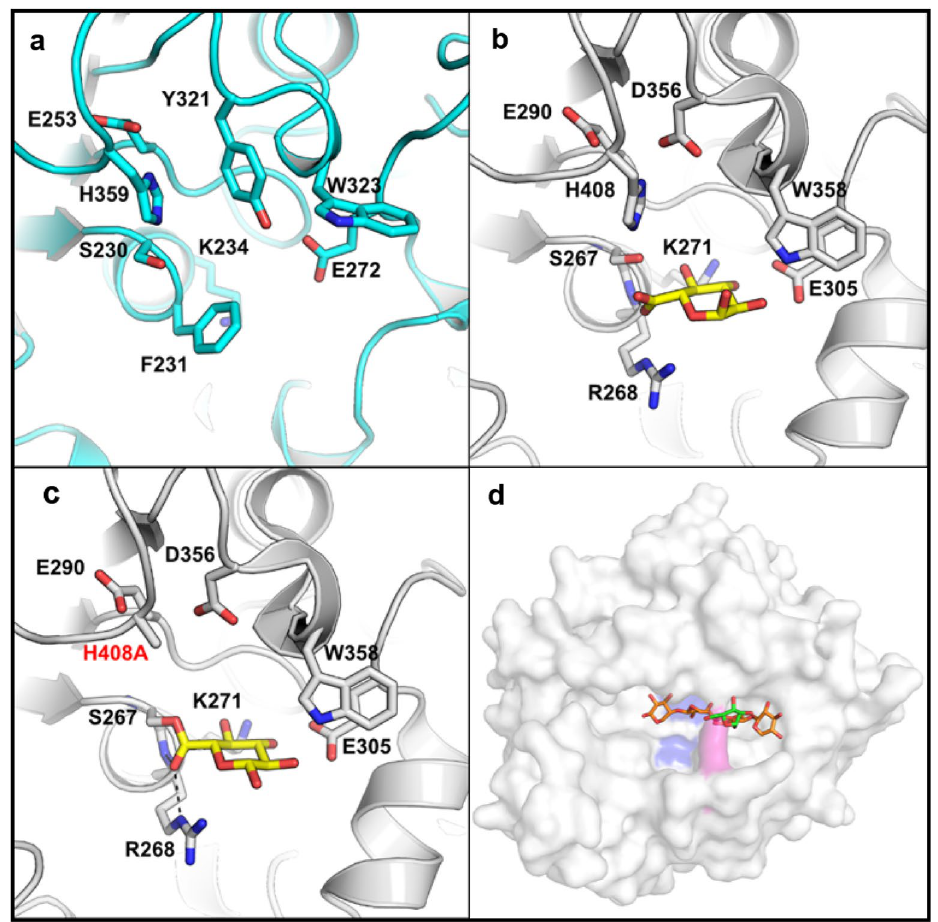
Figure 4. Active site of a homology model of Be CE15A and model structure of Be Rex8A. (a) A homology model of the Be CE15A was generated with Phyre2 56 using the CE15 from Hypocrea jecorina (PDB ID: 3PIC) as a template and compared to structures of (b) the wild type Ot CE15A (PDB ID: 6SYR) in complex with glucuronate (yellow sticks) and (c) a H408A variant of Ot CE15A (PDB ID: 6SZ4) which was trapped with glucuronate covalent adduct and shows the interaction with the usually conserved active site arginine. The equivalent position in Be CE15A is predicted to be a phenylalanine (Phe231). (d) The model structure of Be Rex8A was generated by Phyre2 56 and based on Pb Rex8A (PDB ID: 6TRH). The catalytic residues are shown in blue. The Arg670 residue is shown in purple. The arabinoxylooligosaccharide from Pb Rex8A is modelled into the active site. The figure was made using PyMOL